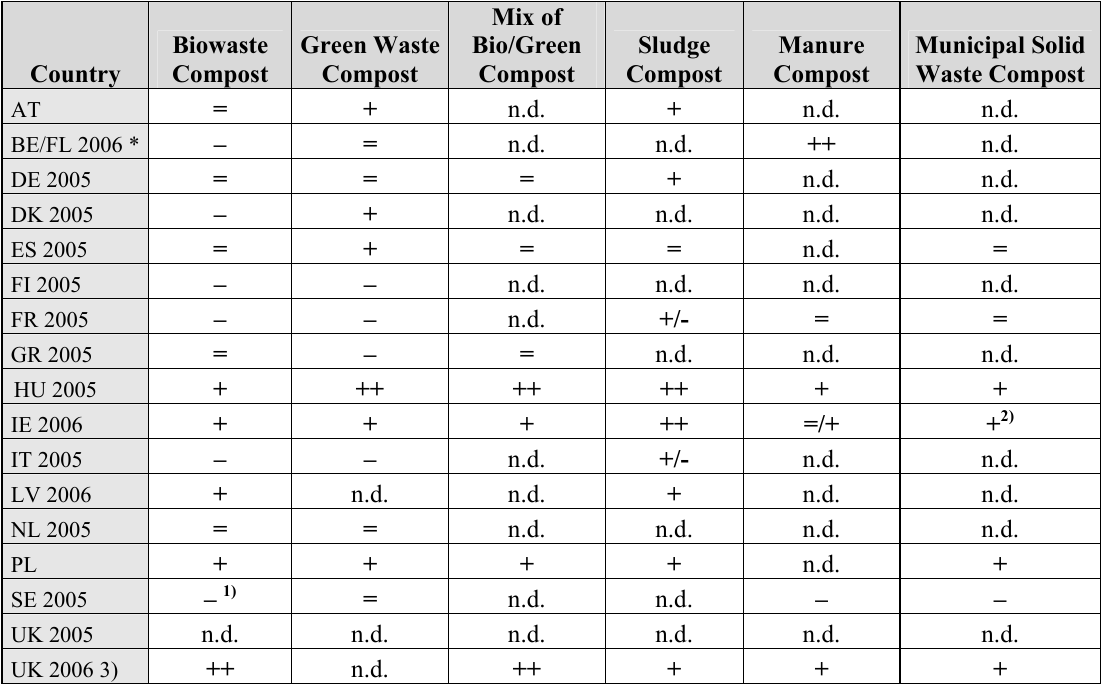
Table 33: Estimated trends in compost production for the main compost types